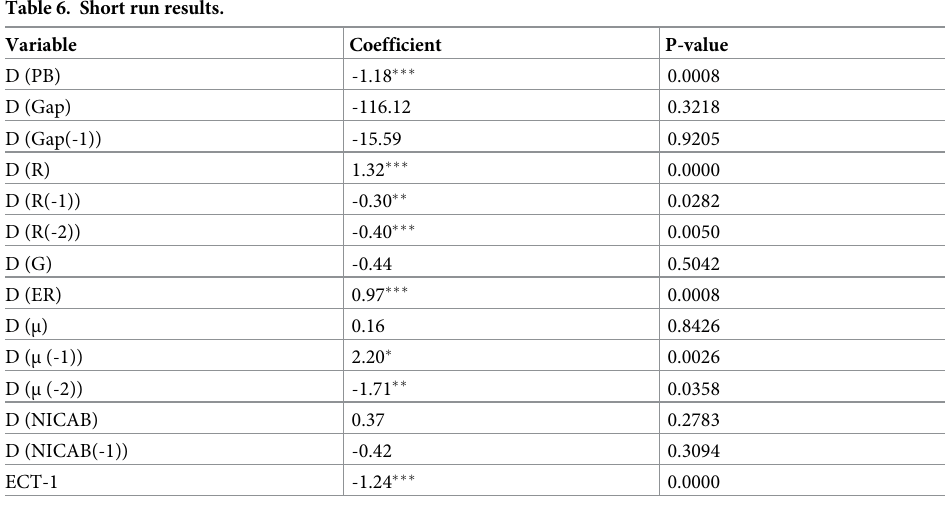
The ��� , �� , � denote statistical significance at the 1%, 5% and 10% level.